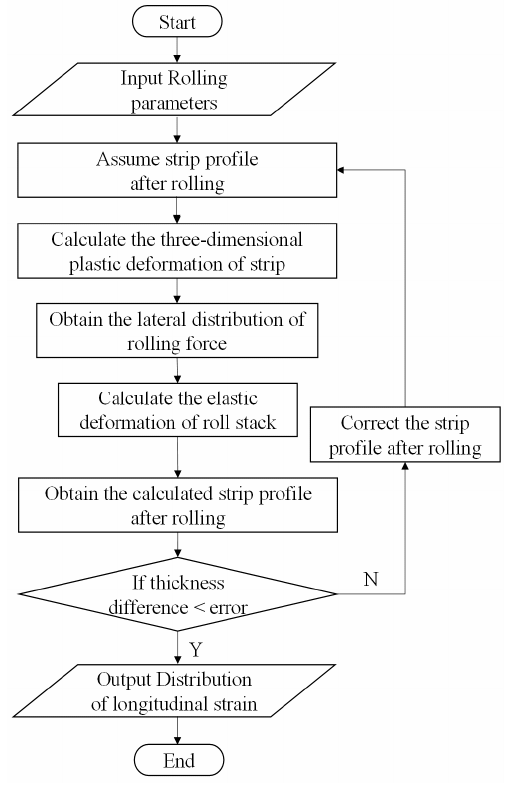
Figure 2. Flow chart of the RDMF model.